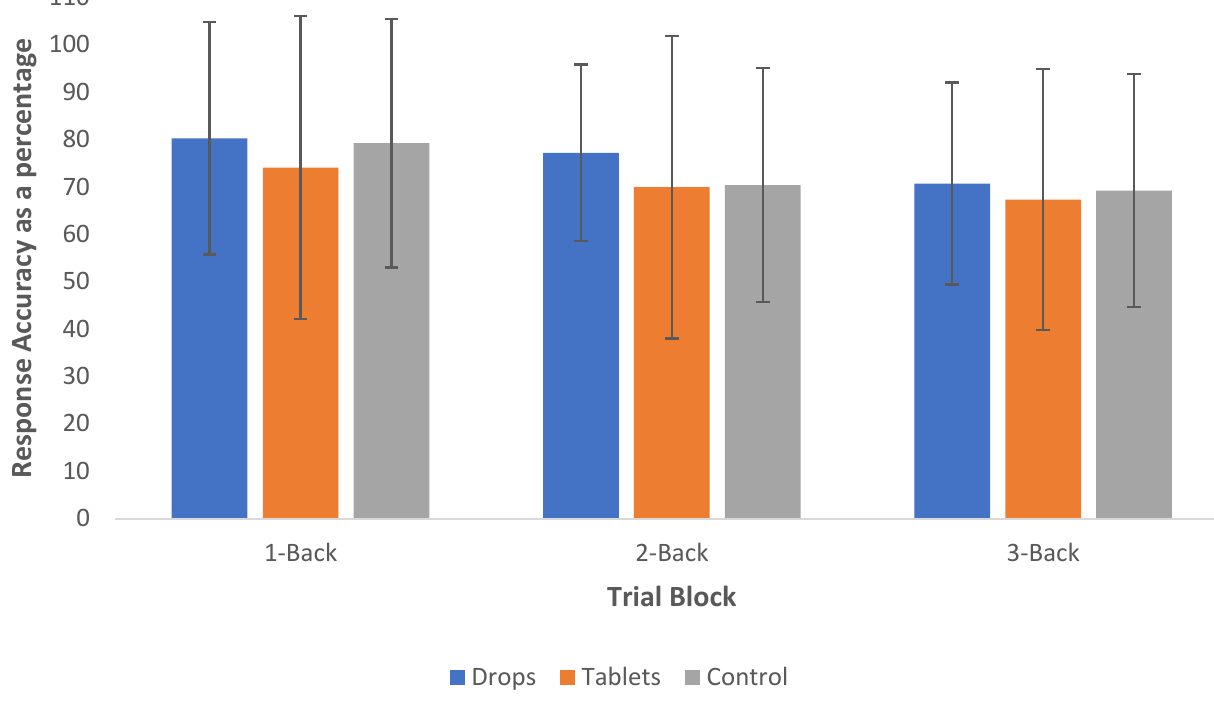
Figure 2. Mean response accuracy and standard deviation of the 1-back, 2-back and 3-back trials of CBD sublingual drop users, CBD tablet users and the control group.